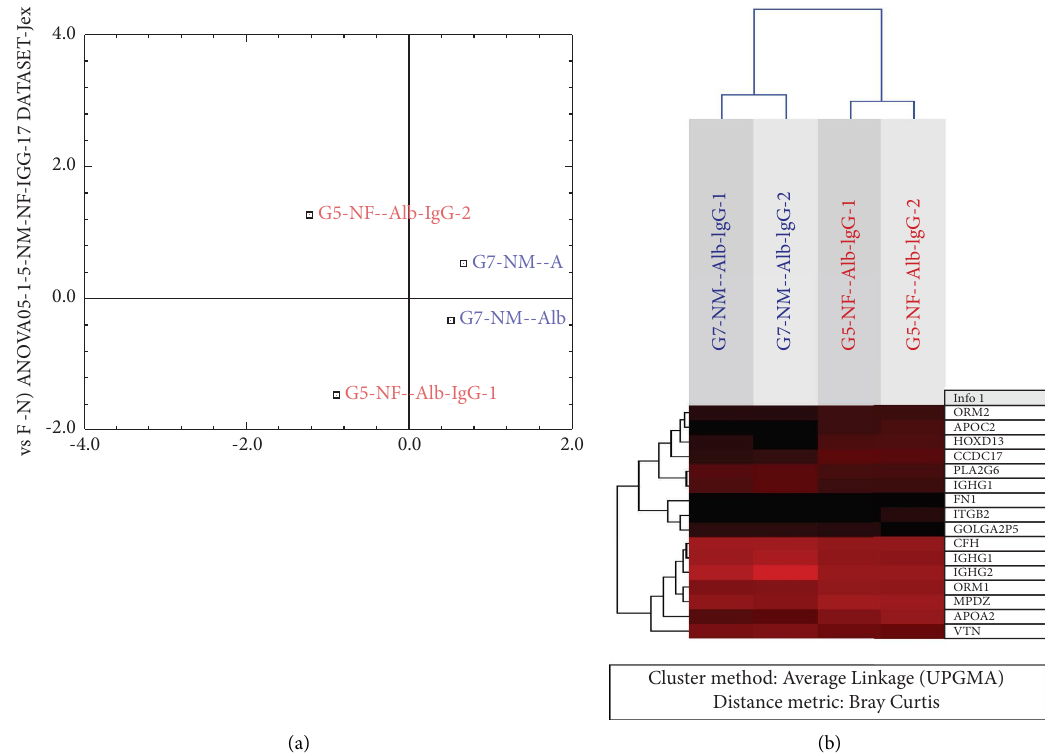
Figure 2: (a) Correspondence analysis (CA) plot of healthy subjects’ nondepleted serum using the expression dataset of 15 identifed proteins/peptides (PPs) that were signifcantly diferentially expressed ( P < 0.05-ANOVA, MFC (minimum fold change) ≥ 1.5-) between men and women. Te expression profles of the identifed PPs distinctively diferentiate women from men using correspondence analysis. Te letters in the background are the accession numbers of all the identifed PPs in the analysis. (Te image was generated using J-express pro V1.1 software program (java.sun.com)). (b) Unsupervised hierarchical cluster analysis of the expression profles of nondepleted serum samples using 17 PPs that difer signifcantly ( P < 0.05-ANOVA, MFC ≥ 1.5) between men (blue) and women (red). Te dendrogram was generated using the Bray–Curtis correlation distance metric and an average linkage clustering method from the J-express pro V1.1 software program (java.sun.com). Note . One PP (IGHG1) had 2 accession numbers (subtypes of the same PP) are shown in the fgure as two diferent